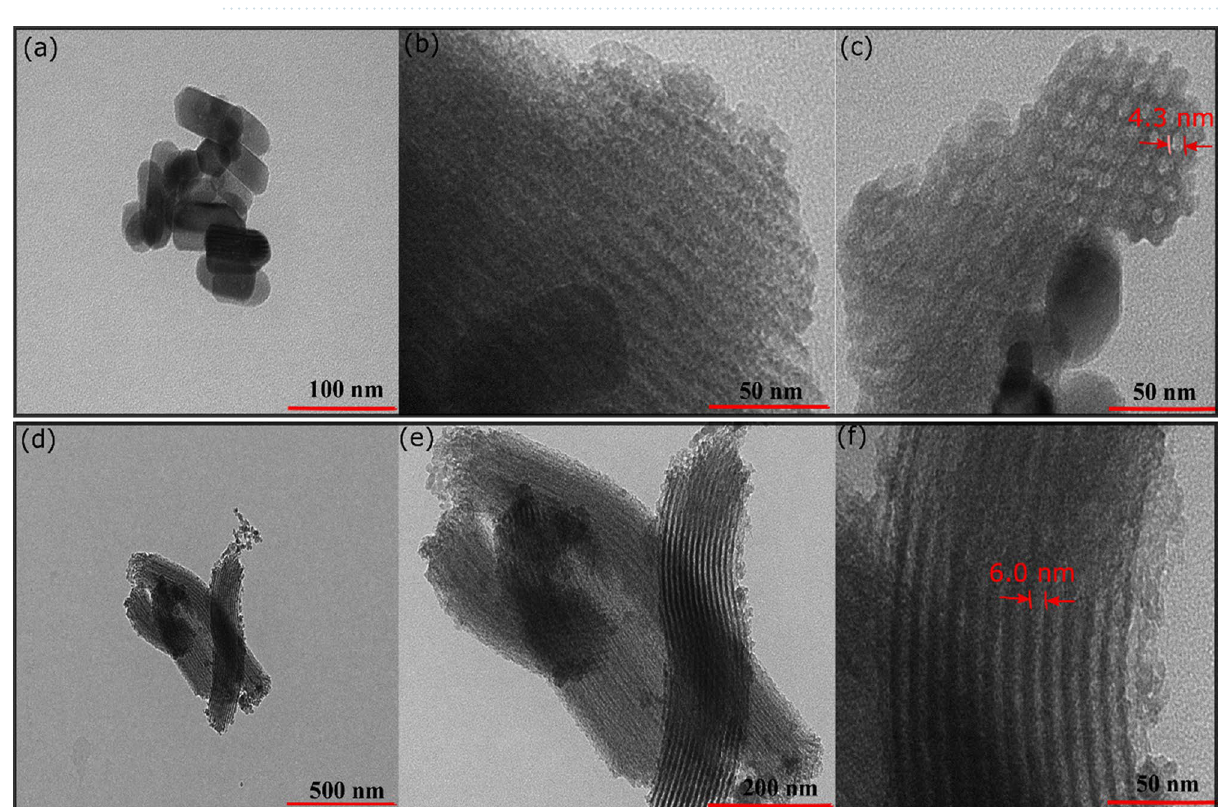
Figure 3. TEM analysis of NS ( a – c ) and NSG-1% ( d – f